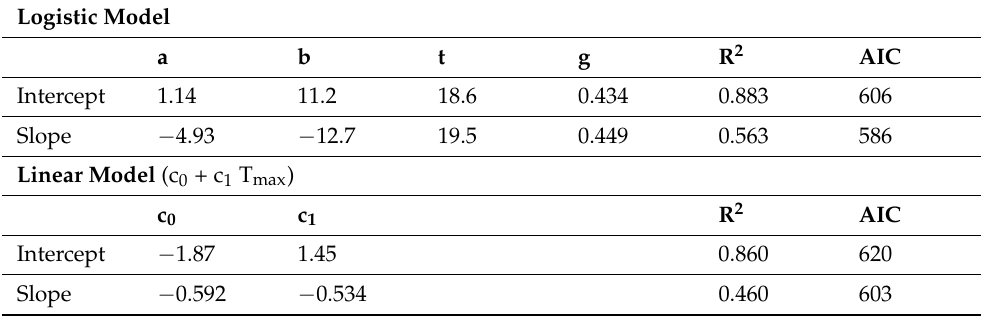
Table 1. Model parameters—Aqua.